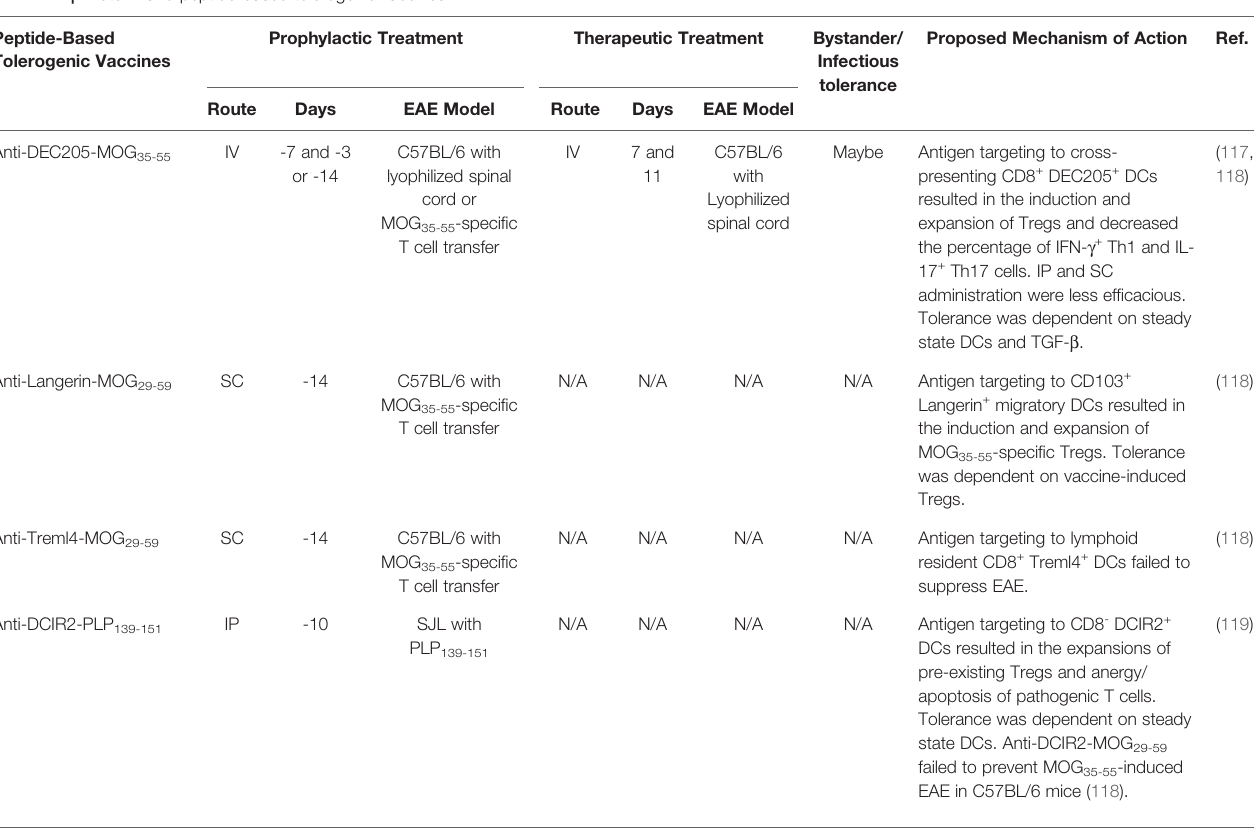
TABLE 2 | Protein- and peptide-based tolerogenic